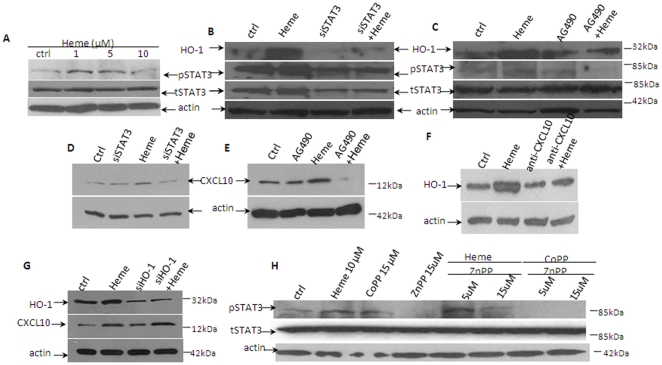
STAT3 activation is induced by Heme in CRL-2581 cells.Decreased activation of STAT3 by siRNA-STAT3 (siSTAT3) and AG490 down regulates HO-1 and CXCL10 protein. pSTAT3 was increased by Heme from 1 µM and peaked at 5 µM and then decreased (A). When pSTAT3 was reduced by siSTAT3 (B) or pharmacological inhibitor of Jak, AG490 (C), HO-1 protein expression was inhibited correspondingly. These data indicated that Heme induced production of HO-1 by way of STAT3 signaling pathway. Reduced activation of STAT3 caused by siSTAT3 (Figure 8D) and AG490 (Figure 8E) also caused reduced expression of CXCL10. We futher found when CXCL10 was blocked by anti-CXCL10 antibody, HO-1 induction by Heme was decreased to one half, indicating that CXCL10 directly induce HO-1 expression (Figure 8F). Reduced HO-1 expression by siHO-1 increased CXCL10 expression which implies that HO-1 also modulates CXCL10 expression (Figure 8G). Interestingly, pSTAT3 level was increased by CoPP and decreased by ZnPP (Figure 8H), which indicates that HO-1 also regulates STAT3 signaling.